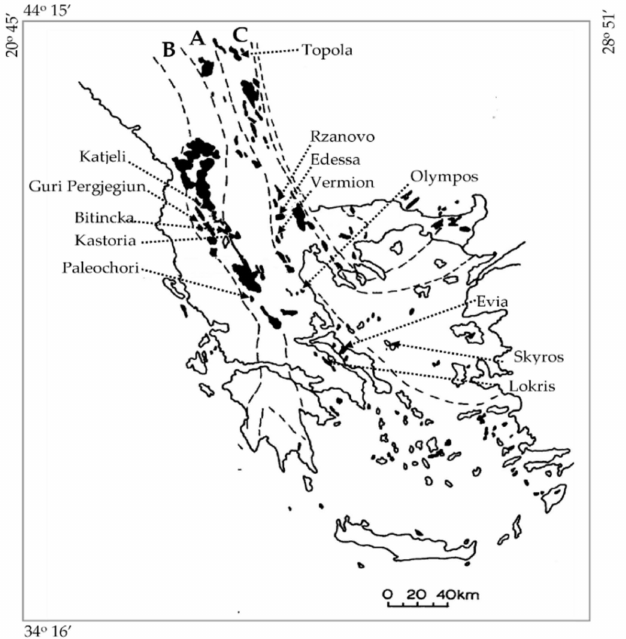
Figure 1. Sketch map showing the Pelagonian (A), Sub-Pelagonian (B), and Axios (C) geotectonic zones in the Balkan Peninsula, and the distribution of ophiolites and the associated Fe–Ni ± Co laterite